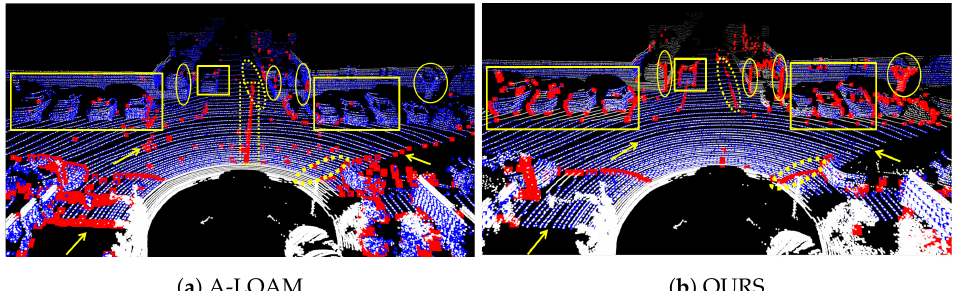
Figure 5. The comparison of feature extraction after applying A-LOAM and our algorithms, respec- tively, at an intersection. Edge and planar features are colored red and blue, respectively. The yellow rectangles and ellipses are used to compare the accuracy of different feature extraction methods.